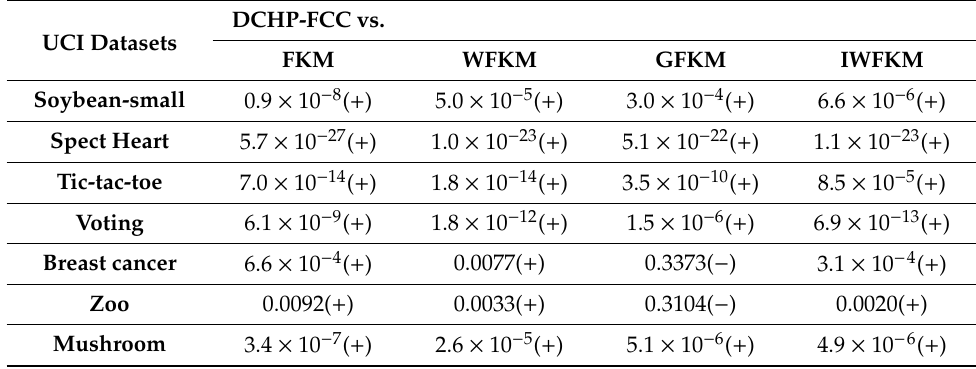
Table 5. The p -value produced by the T -test in terms of ARI.